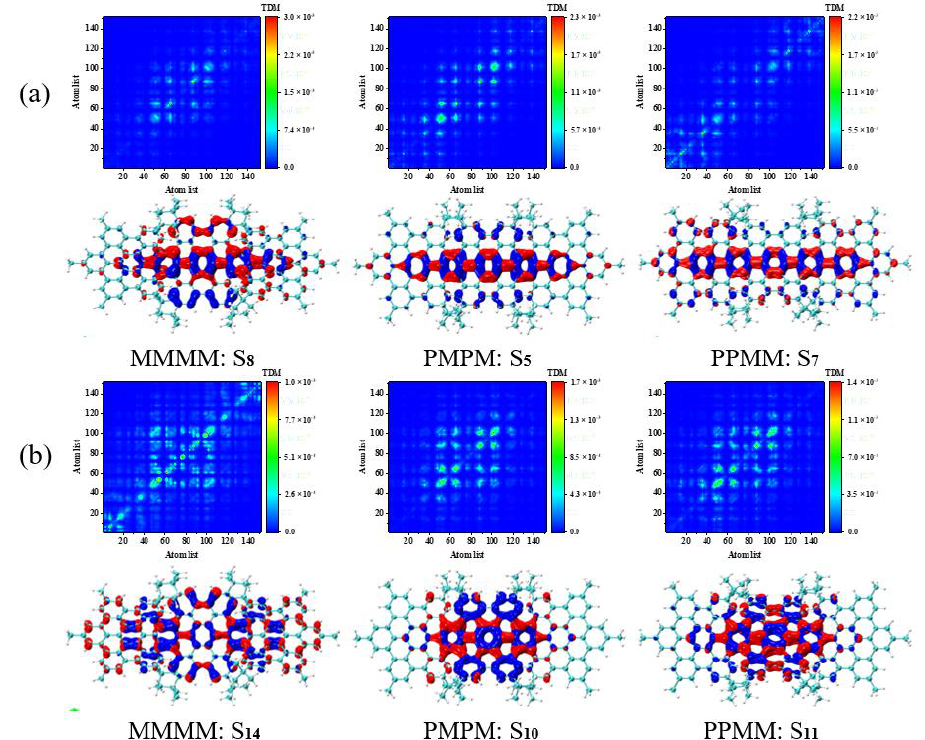
Figure 5. The TDM and CDD of three isomeric molecules’ excited states at 330–390 nm in the spectrum. ( a ) The TDM and CDD diagrams of the excited state corresponding to the strong peak are S8 of MMMM, S5 of PMPM and S7 of PPMM, respectively; ( b ) the TDM and CDD diagrams of the excited state corresponding to the sub-strong peak are S14 of MMMM, S10 of PMPM and S11 of PPMM, respectively.